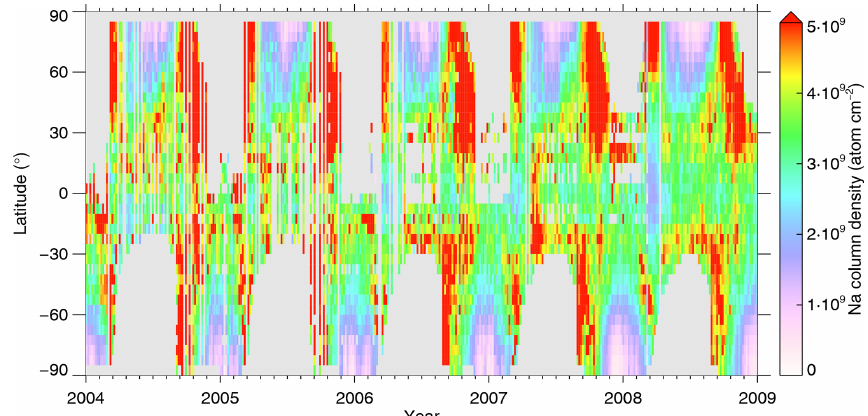
Figure 3. Time–latitude distribution of the Na column number density from the OSIRIS limb-scanning radiance measurements made by the Odin satellite, with a resolution of a 5d × 5 ◦ latitude grid. Na column density is integrated from 70 to 120km altitude. Grey-shaded areas indicate the regions where OSIRIS limb-scanning radiance measurements were not made in winter.